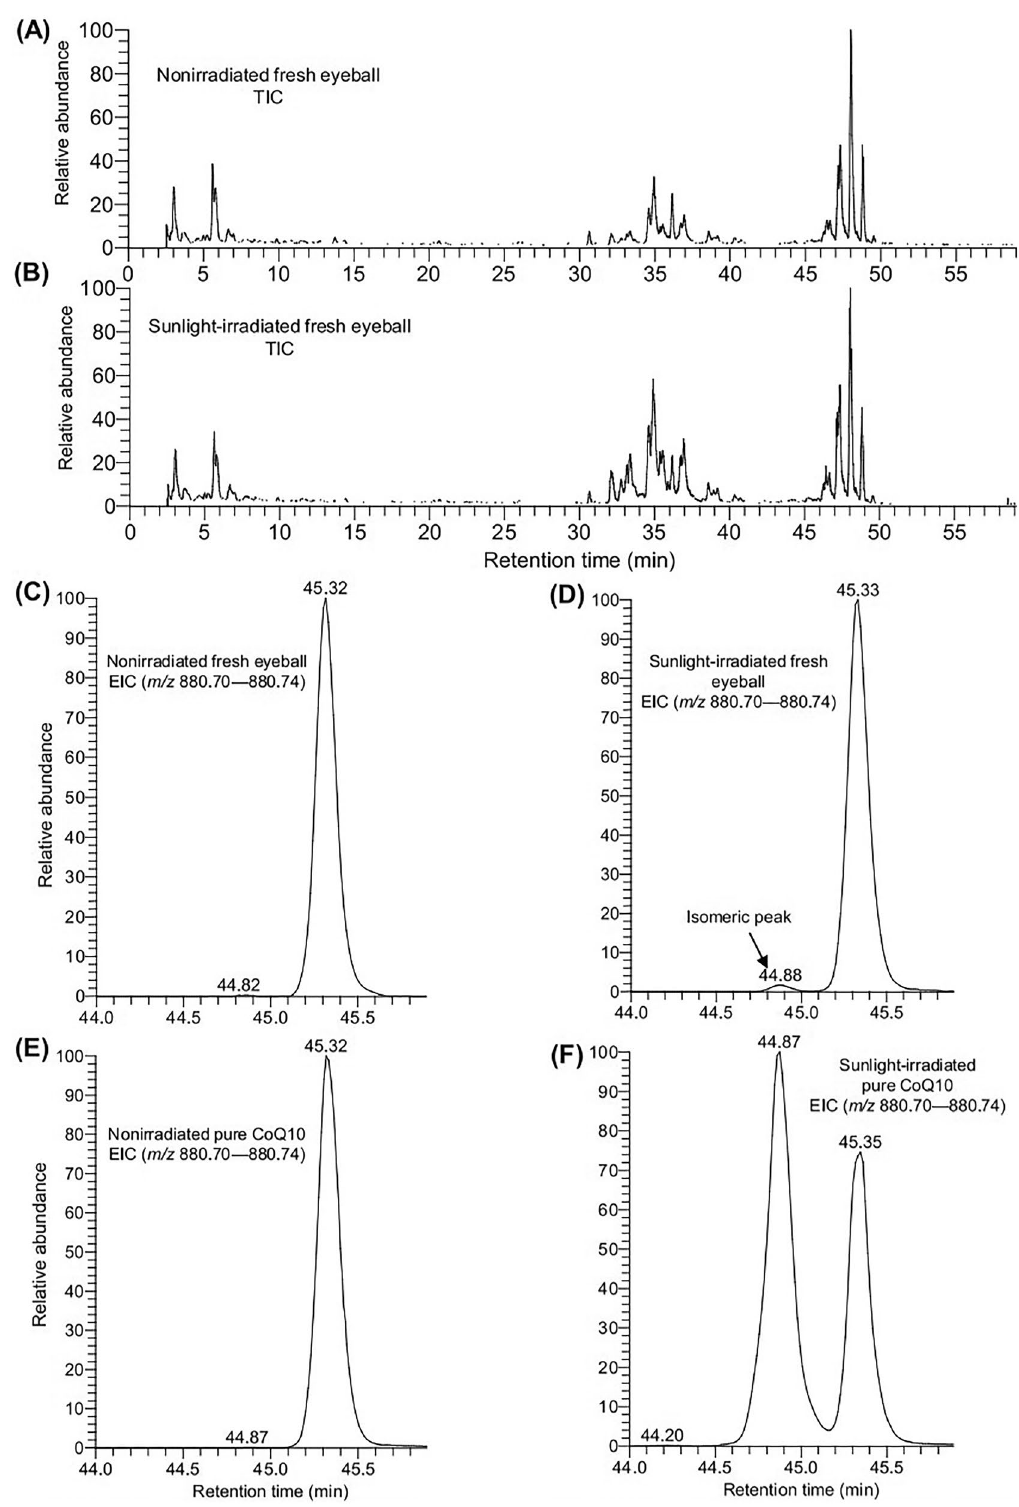
Figure 5. LC/MS data of fresh eyeball and pure CoQ10. TIC of ( A ) nonirradiated and ( B ) sunlight-irradiated fresh eyeball. The data shown here were obtained in positive ion mode. EIC of CoQ10 in ( C ) nonirradiated and ( D ) sunlight-irradiated fresh eyeball. EIC of CoQ10 in ( E ) nonirradiated and ( F ) sunlight-irradiated pure